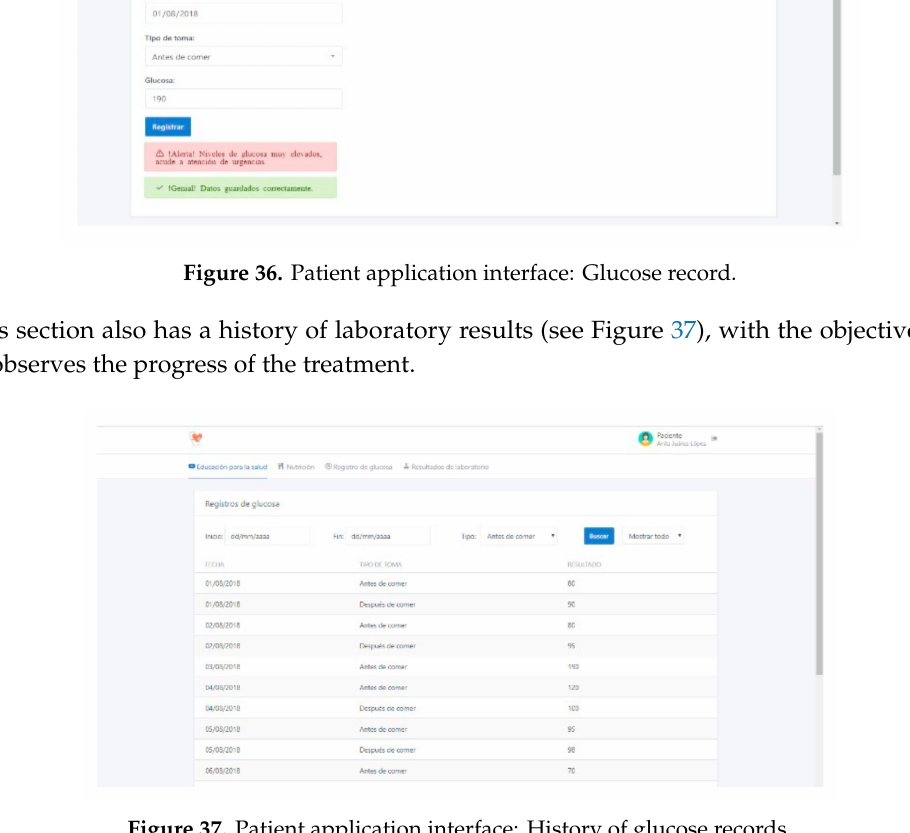
Figure 37. Patient application interface: History of glucose